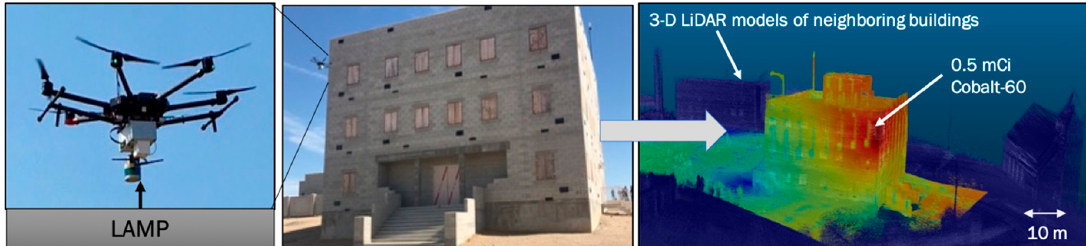
Figure 7. The localization and mapping platform (LAMP) in combination with a 2 × 2 CsI gamma-ray detector array mounted on a DJI Matrice-600 while flying around a building. The data product on the right shows the reconstructed model of the building (and other buildings) and the reconstructed radiation field fused with the surface of the building, pointing to the location of the Co-60 source in the correct corner of the building. The blurred image reflects the overall radiation field which was dominated by the scattered radiation in the concrete wall and the limited spatial resolution of the instrument which localized based on proximity and not based on properly imaging.